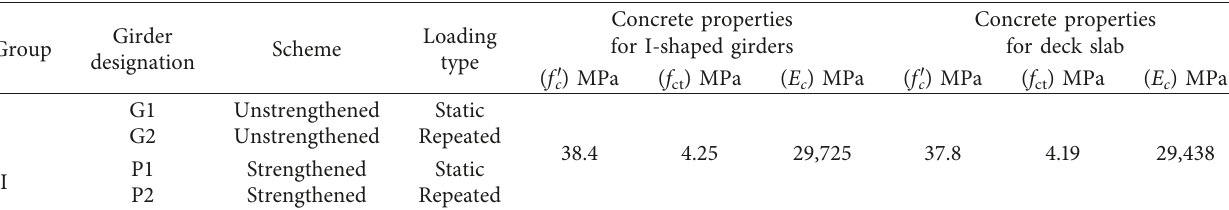
Figure 1: Dimensions and reinforcement details of the tested girders. (a) Dimensions and prestressing reinforcement details. (b) Nonprestressing reinforcement details. Table 1: Girders details and concrete test